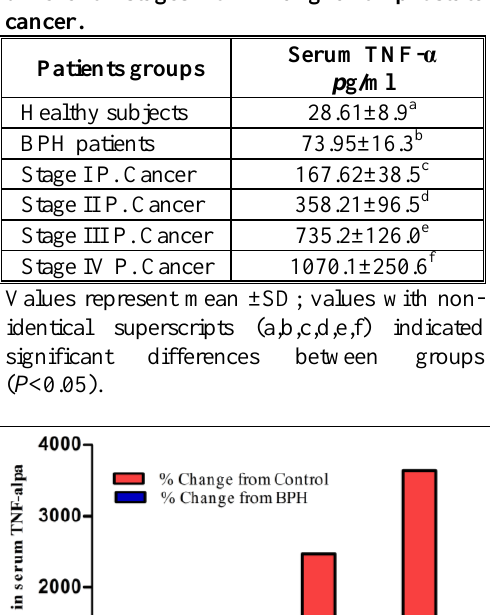
Table 1: Serum levels of TNF-α in healthy